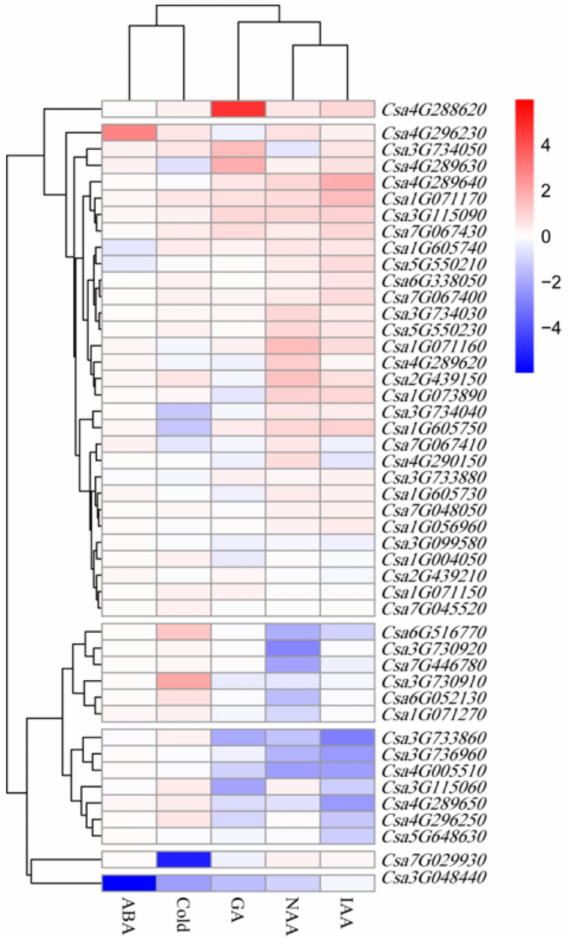
Figure 6. Expression analysis of CsLecRL K genes in response to di ff erent treatments. The heatmap represents the fold-change of expression level under five treatments: gibberellin (GA), abscisic acid (ABA), 1-Naphthaleneacetic acid (NAA), indole-3-acetic acid (IAA) and cold